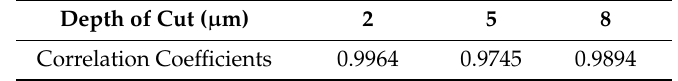
Figure 7. The change of roughness value Ra of machined grooves with spindle speed under different depth of cut. Table 2. The correlation coefficients between the static component of thrust force and roughness value Ra of machined grooves with spindle speed under different depth of cut.